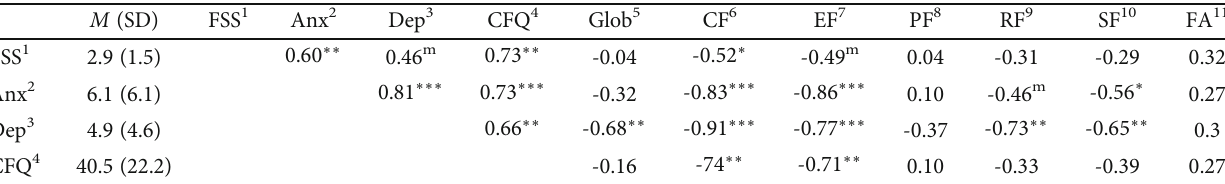
(b) Descriptive statistics and correlations between main variables at one-year follow-up ( T 1